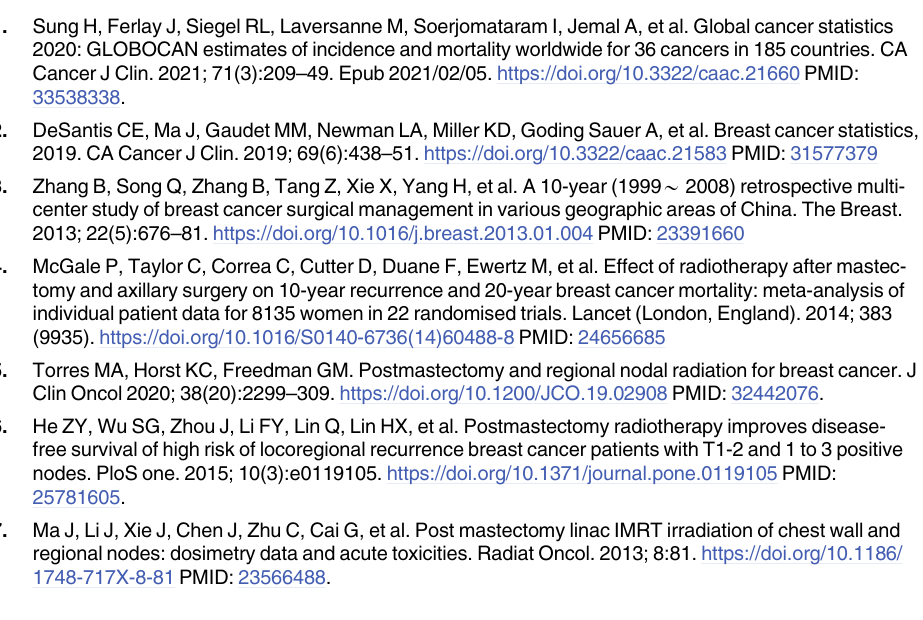
S2 Fig. Underdosed volumes in CTV (red) in VMAT-5B (orange) and VMAT-10B (dark green) with setup errors in the inferior direction for a typical patient. (TIF) S1 File. Dosimetry data of the targets and OARs for the patients with VMAT-5B and VMAT-10B. (XLSX) S2 File. Dosimetry of the targets and OARs for the patients with perturbed plans. (XLSX) S1 Table. Monitor units for the original plans in this study.